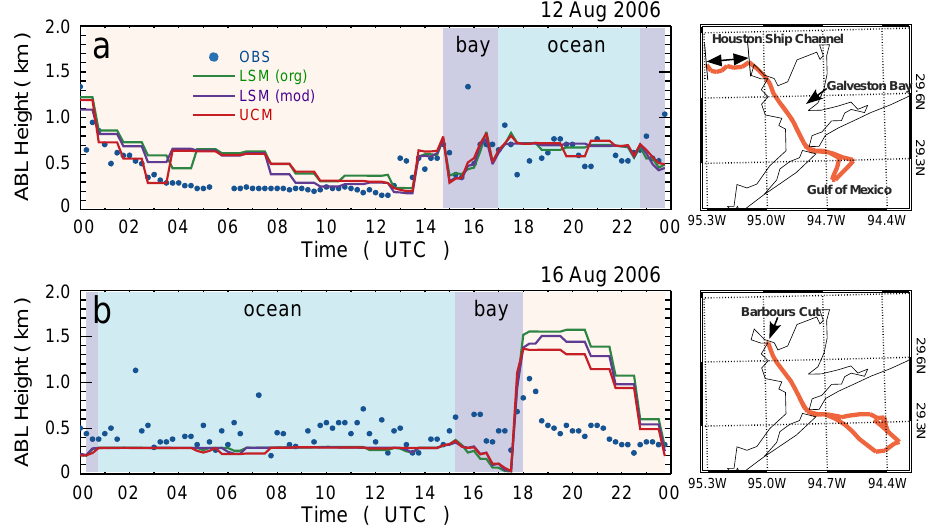
Fig. 16. Comparison of observed and simulated ABL heights (left panels) along the ship tracks (right panels) on (a) 12 August and (b) 16 August. Shaded areas indicate time periods when the ship was located in Galveston Bay (“bay”) or the Gulf of Mexico (“ocean”). The ship was located in the Houston Ship Channel area or stationed at Barbours Cut during the other periods of the